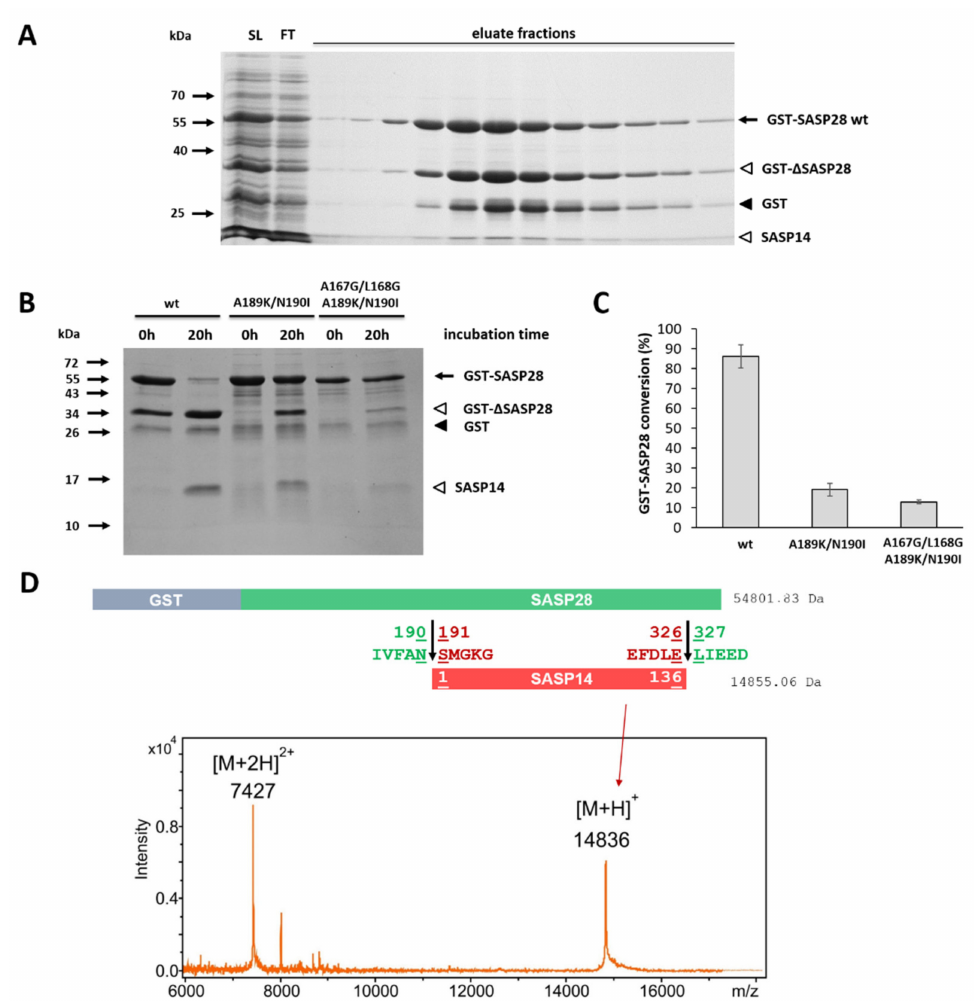
Figure 10. Autoproteolysis of di ff erent GST-SASP28 forms. ( A ) A representative gel image shows the SDS-PAGE analysis of soluble lysate (SL), flow-through (FT), and eluate fractions from the a ffi nity-purification of wild-type GST-SASP28. ( B ) All purified GST-SASP28 enzyme forms were incubated for 0 and 20 h. Black arrow indicates full-length GST-SASP28 wt, white arrowheads indicate GST- ∆ SASP28 and SASP14 as autoproteolytic cleavage fragments, while GST is shown by black arrowhead in the representative gel image. ( C ) After the incubation of GST-SASP28 enzymes (see figure part B ), densitometry was performed to determine conversion of precursors. The conversion of was determined by comparing the band intensity of the precursor before and after incubation. Band intensity of the non-incubated precursor was considered to be 100% for each enzyme form. Error bars represent SD ( n = 2). ( D ) Identification of SASP14 released by autoproteolysis of GST-SASP28 precursor. After self-processing, SASP14 was detected by MALDI TOF MS. Calculated molecular weights are shown together with the schematic representation of processing, while MS spectrum shows the identified fragment. Unedited gel images are represented in Figure